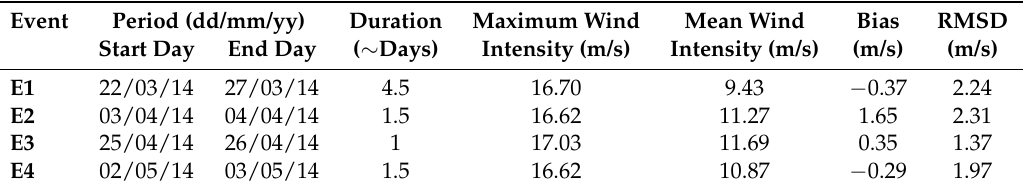
Table 1. Main characteristics of the NW wind-jet events at point P2 according to WRF model results. Error metrics comparing DB data and WRF results are shown in terms of RMSD and